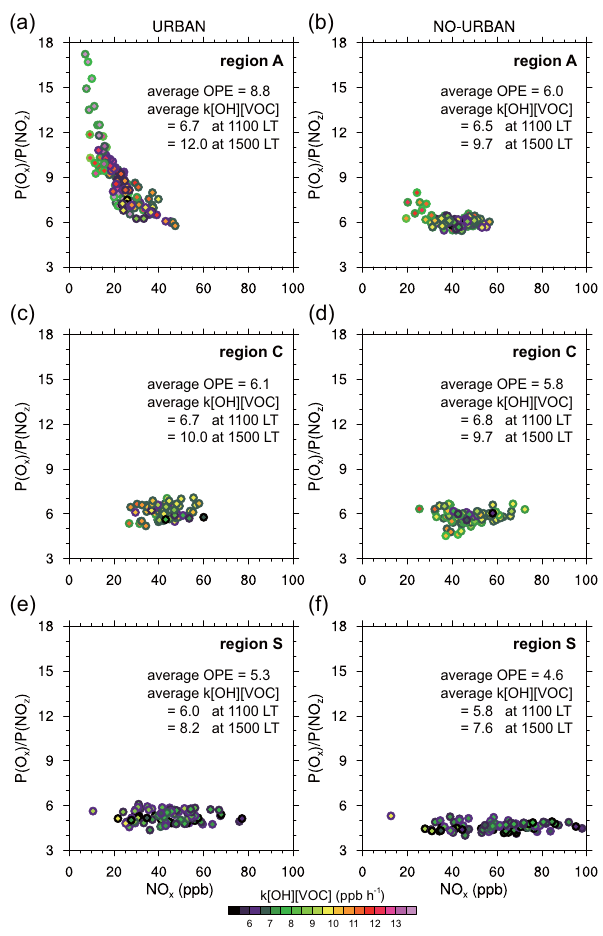
Fig. 13. Scatter diagrams of ozone production efficiency [OPE, calculated as P(O x ) /P(NO z ) ] and NO x concentration at 15:00 LT in the (a) URBAN and (b) NO-URBAN simulations in region A, the (c) URBAN and (d) NO-URBAN simulations in region C, and the (e) URBAN and (f) NO-URBAN simulations in region S. The values of average OPE are the values at 15:00 LT. The color of outer (inner) circles indicates the rate of reactions between OH and VOCs, denoted by k [OH][VOC], at 11:00 (15:00) LT. The unit of k [OH][VOC] is ppbh − 1